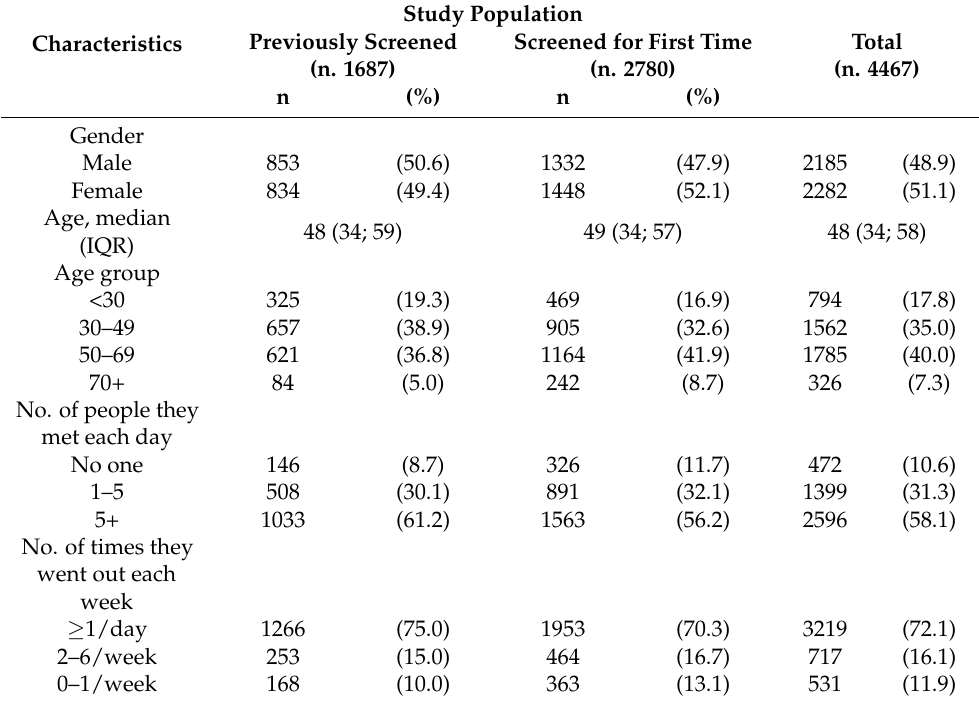
Table 1. Characteristics of the study population.